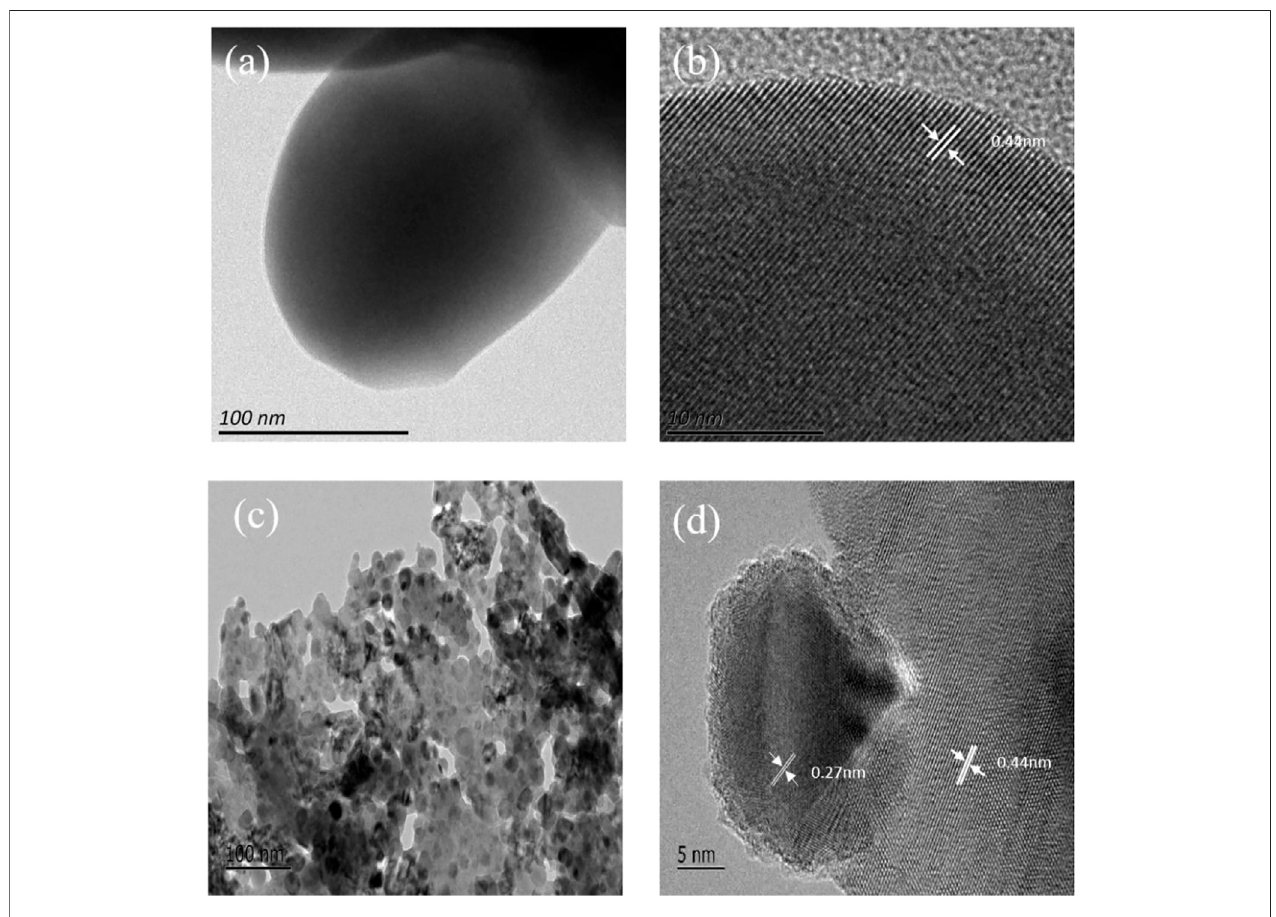
FIGURE 3 | TEM images of (A,B) Nb 2 O 5 and (C,D) 10Ni-10Mn/Nb 2 O 5 catalysts.